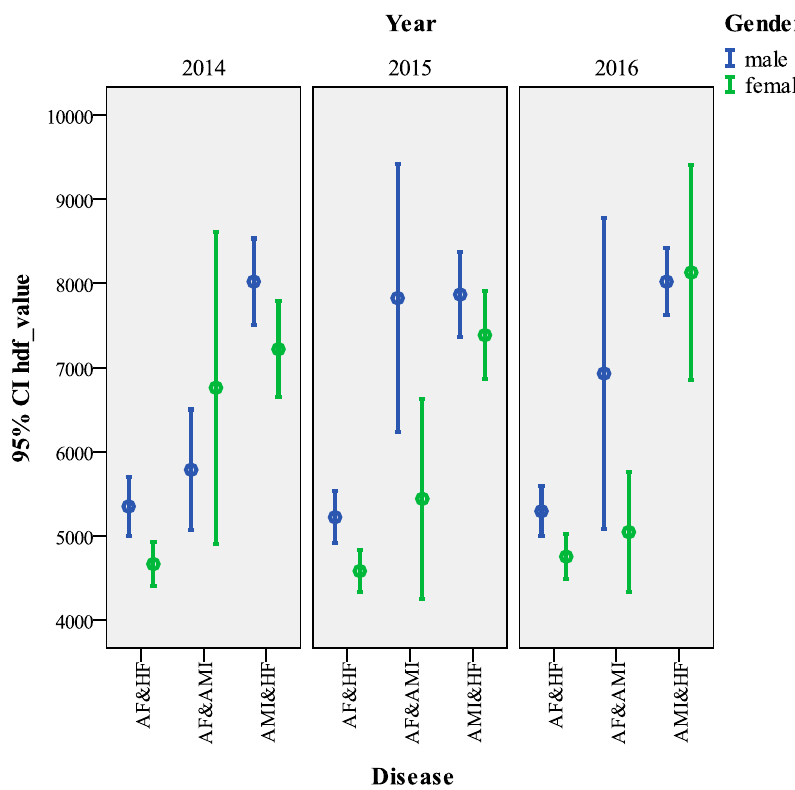
Figure 3. Errorbar chart hdf_value by double disease and gender (95% CI).